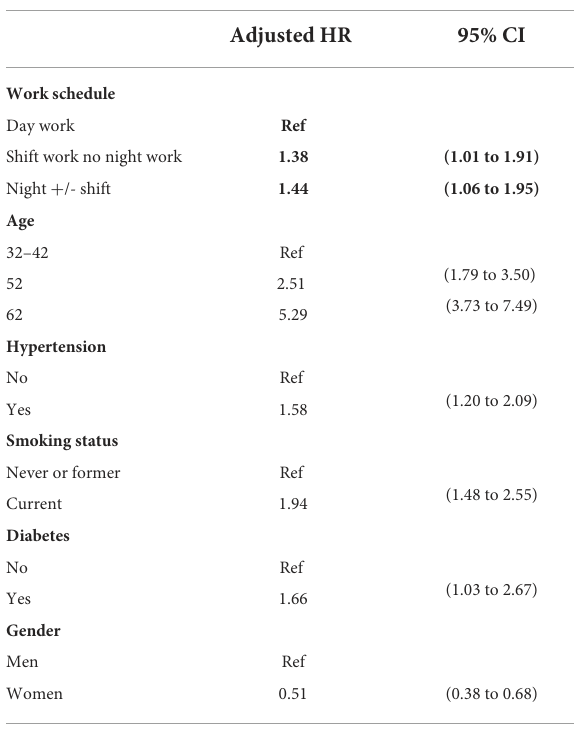
TABLE 4 Contribution of individual factors and all combined occupational constraints to mortality in all population, after 20 years of follow-up: Backward